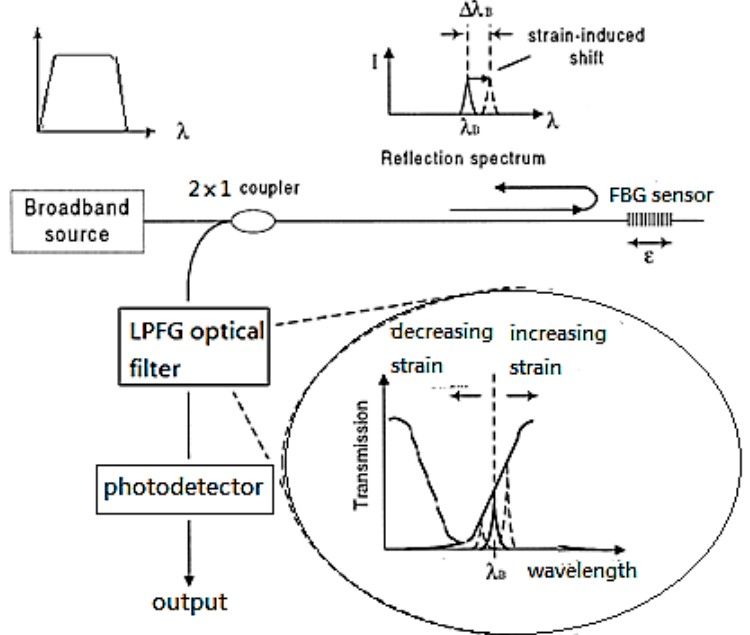
Figure 3. Schematic diagram of the integrated optical fiber sensing system.